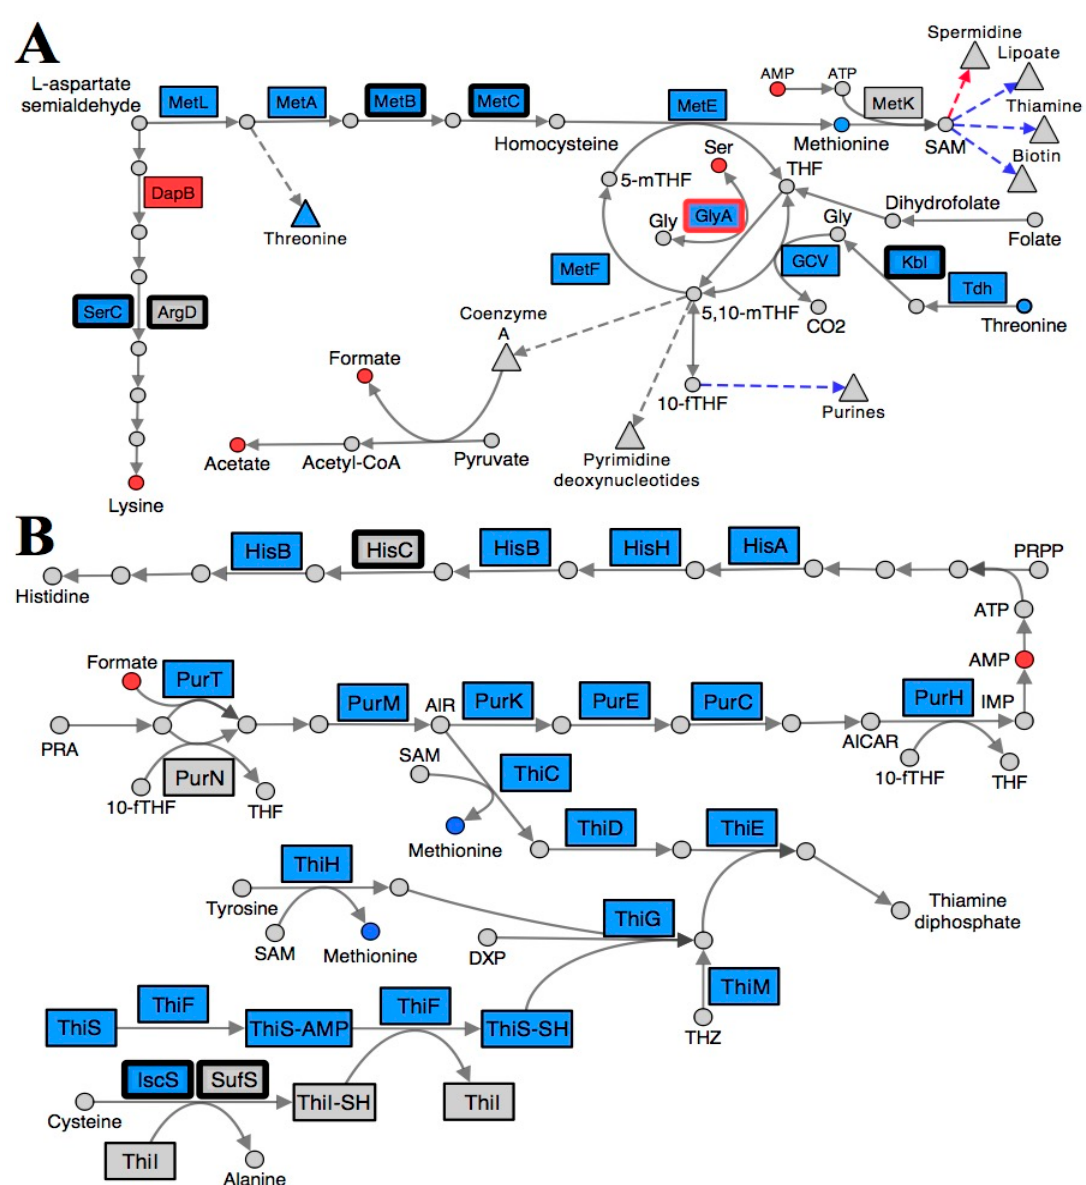
Figure 2. Folate and S-adenosylmethionine pathways are reorganized in a S. enterica ridA mutant. Metabolites (circles) and gene products (rectangles) involved in ( A ) lysine, methionine, and folate biosynthesis and ( B ) purine, histidine, and thiamine biosynthesis are depicted, with each arrow representing a biochemical step in the pathway. Blue shading denotes a significantly (FDR < 0.05) increased abundance of the respective metabolite / transcript in ridA cells, while red shading indicates a significantly decreased abundance in ridA cells. Grey gene products showed no significant di ff erence between wild-type and ridA cells, while grey metabolites were either not identified or not significantly altered. A bold border around a gene product designates enzymes that use PLP as a cofactor. GlyA is a known target for 2AA damage and is shown with a red border. Dashed arrows and triangles indicated general pathways which utilize the metabolite at the base of the arrow, while blue and red colored arrows denote genes involved in biosynthesis of that compound up- or down-regulated,